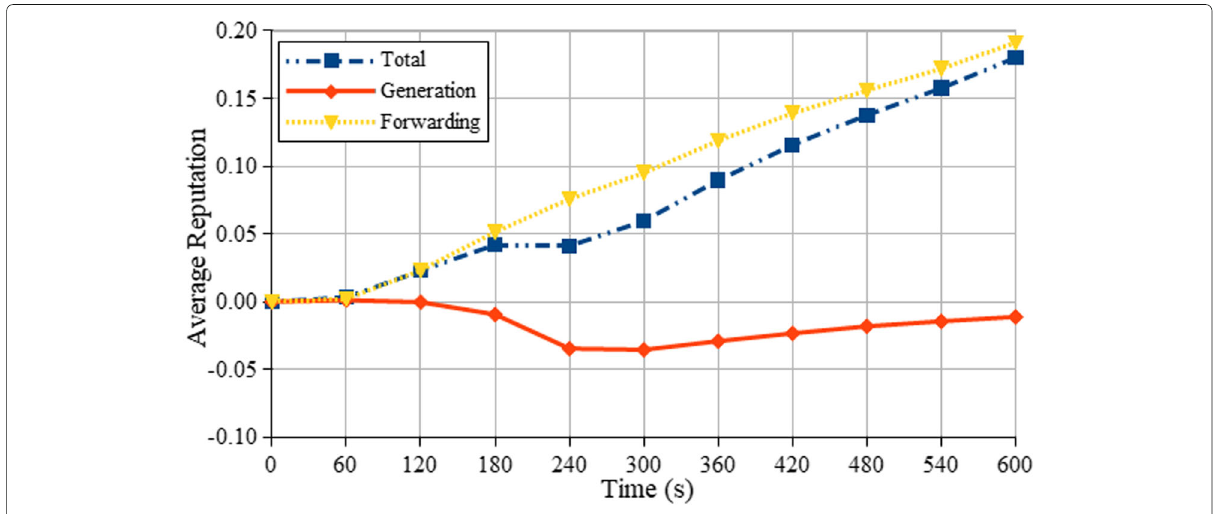
Fig. 9 Results of AR with MV = 50%